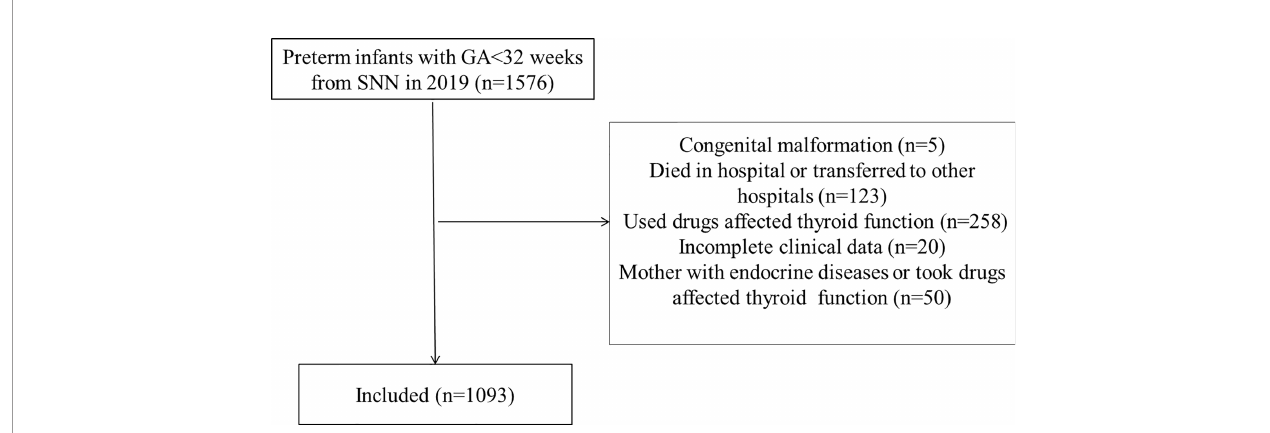
FIGURE 1 | Inclusion fl ow chart.